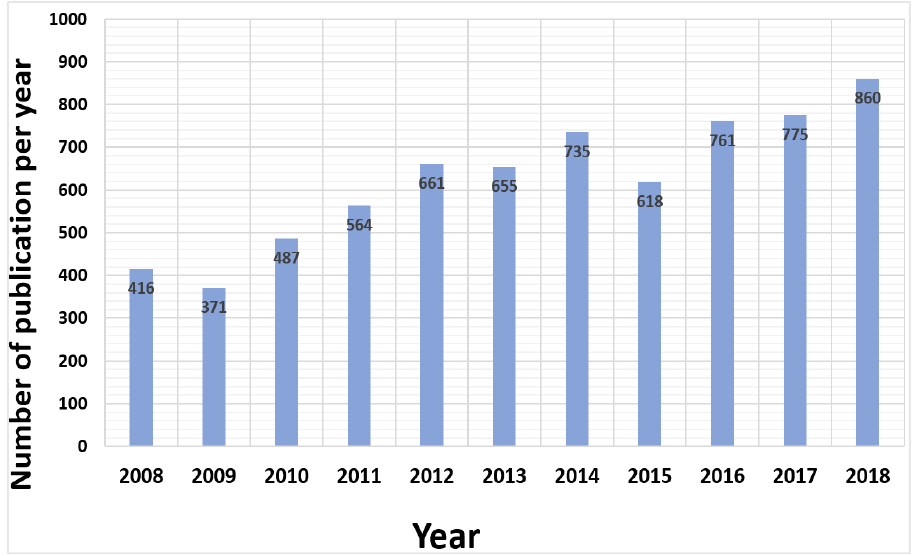
Figure 1. Distribution of global studies on construction accidents from 2008–2018. [Scopus databases].